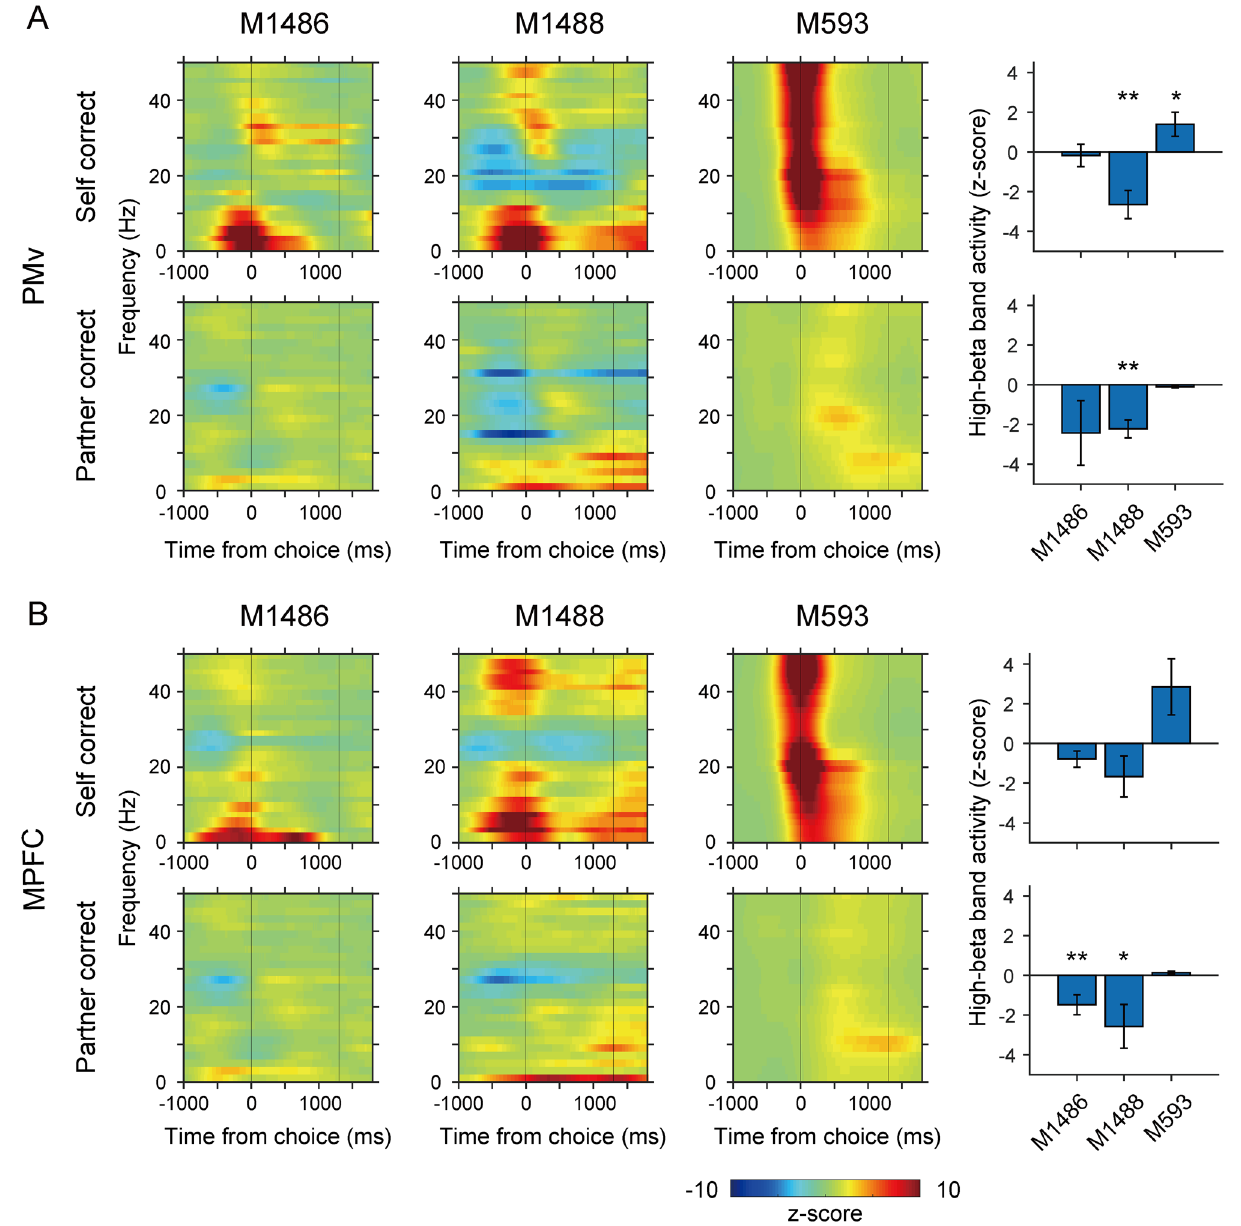
Figure 3. Lack of mu suppression in M593. (A) Left , LFP spectrograms recorded from the PMv for self-correct trials (top) and partner-correct trials (bottom). Vertical lines at 1300 ms indicate the time of reward feedback. Right , quantitative analyses of high-beta band activity (23–30 Hz). Asterisks indicate a significant difference from zero (* P < 0.05; ** P < 0.01; Wilcoxon signed-rank test). ( B ) LFP spectrograms and high-beta band activity in the MPFC. Same conventions as in ( A